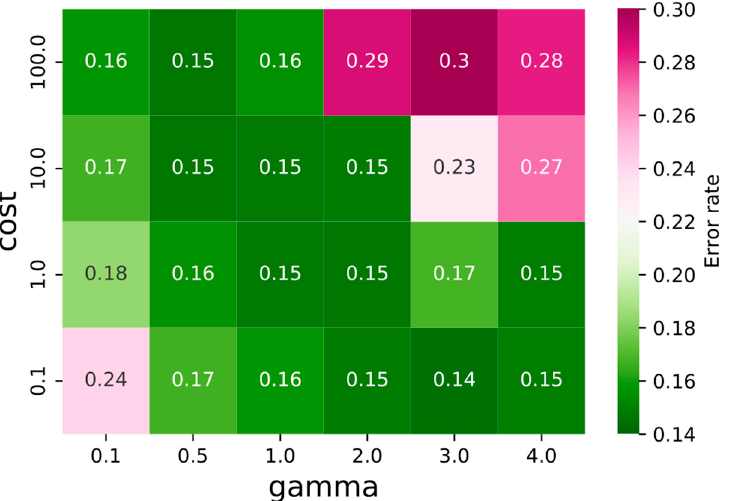
Figure 6. The 10-fold cross-validation error rate of the SVM model under the different cost and gamma. The value in each tile indicates the error rate. gamma. The value in each tile indicates the error